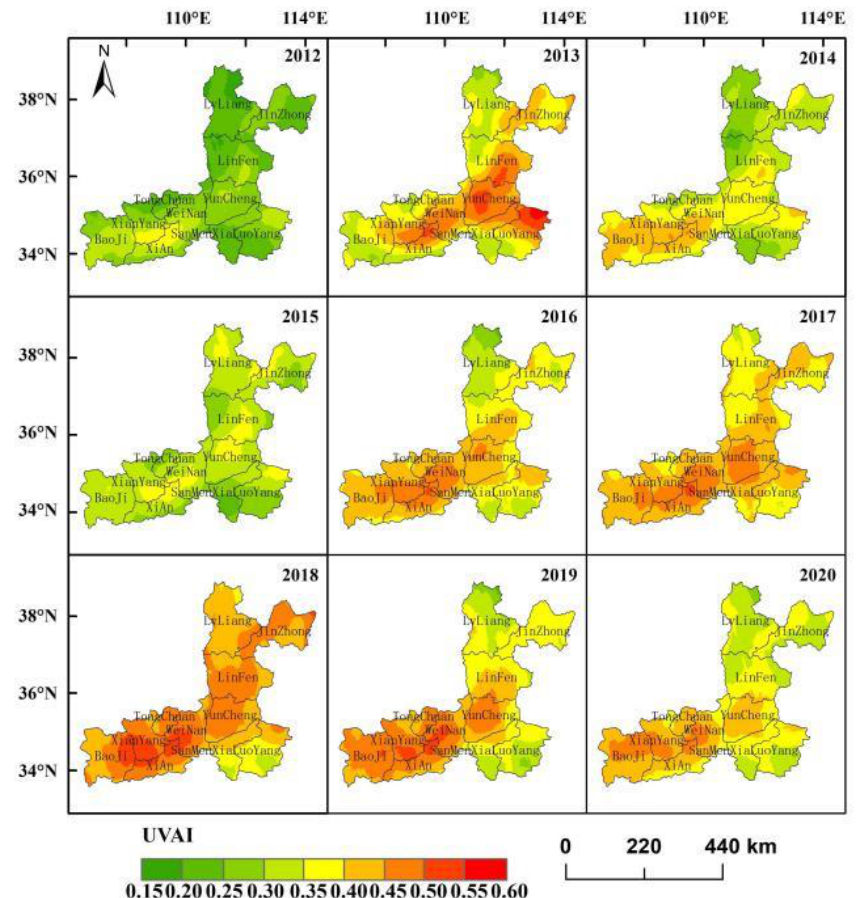
Figure 3. The average annual change of UVAI value in the Fenwei Plain from 2012 to 2020. According to the classification of the mean annual change of UVAI in Figure 3, the proportion of the area occupied by different levels of UVAI was calculated for 9 years (Figure 4a). Figure 4a shows that from 2012 to 2020, the Fenwei Plain as a whole was dominated by 0.35–0.45 of UVAI, followed by the frequency of the fourth level. In general, the annual average change trend of UVAI showed in 2013 and 2018, but the average value in the past five years was significantly greater than the previous four years. From 2012